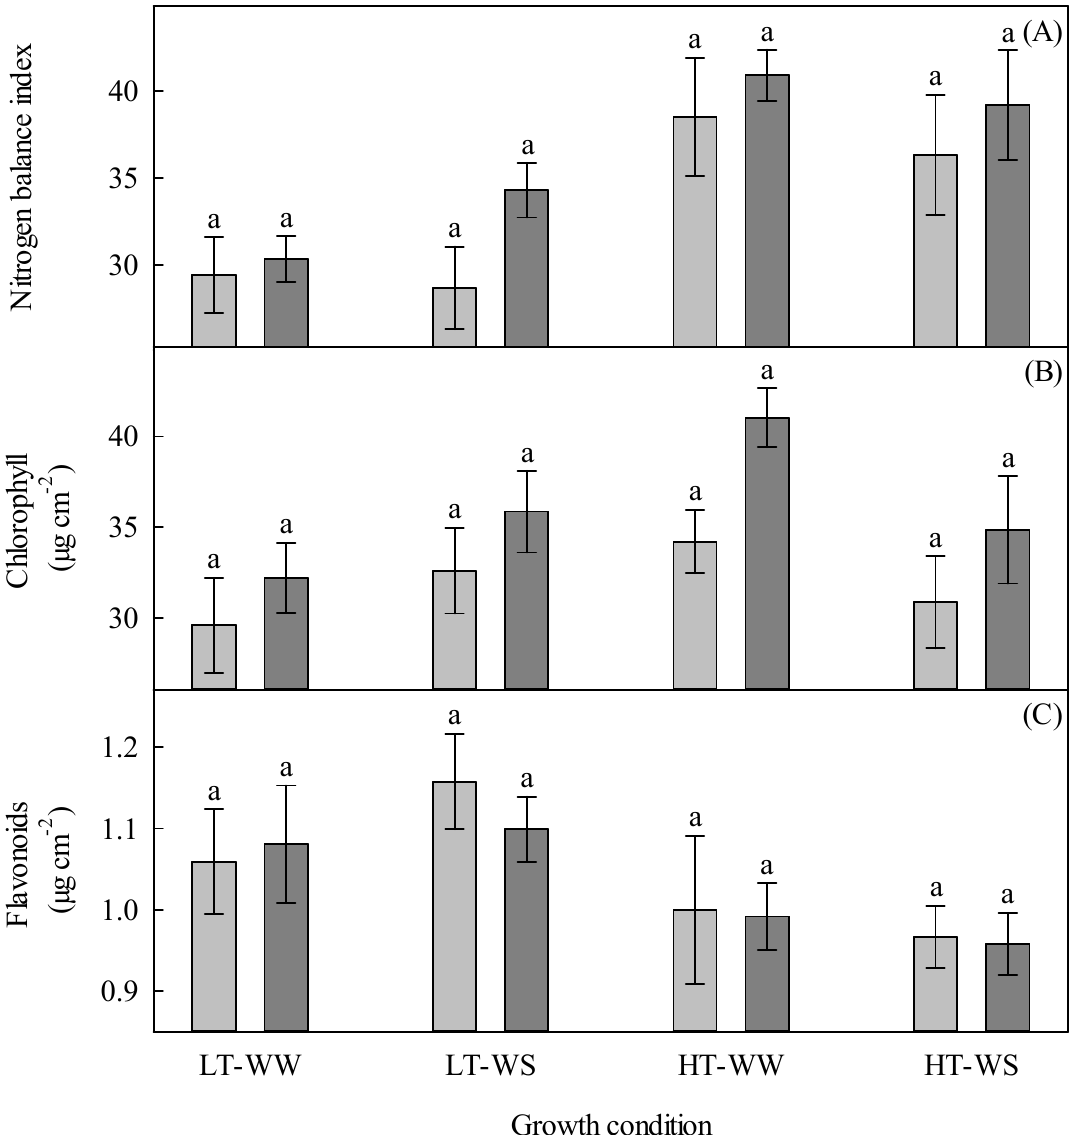
Figure 7. Nitrogen balance index, chlorophyll, and flavonoids of 33-day-old tomato plants grown under eight experimental conditions, including two temperature regimes, two watering regimes, and two abscisic acid concentration applications after 12 days of initial germination and growth in growth chambers with lower temperature, watering to field capacity, and without abscisic acid ap- plication. ( A ) Nitrogen balance index, ( B ) chlorophyll, and ( C ) flavonoids. LT, lower temperature; HT, higher temperature; WW, well-watered; WS, water-stressed; light gray, no abscisic acid; dark gray, abscisic acid. Data are the means ± SE of 91 (nitrogen balance index and flavonoids) and 104 (chlorophyll) samples from three experiments. Bars with different letters above them are signifi- cantly different according to Scheffé’s multiple comparison procedure at the 5% confidence level.